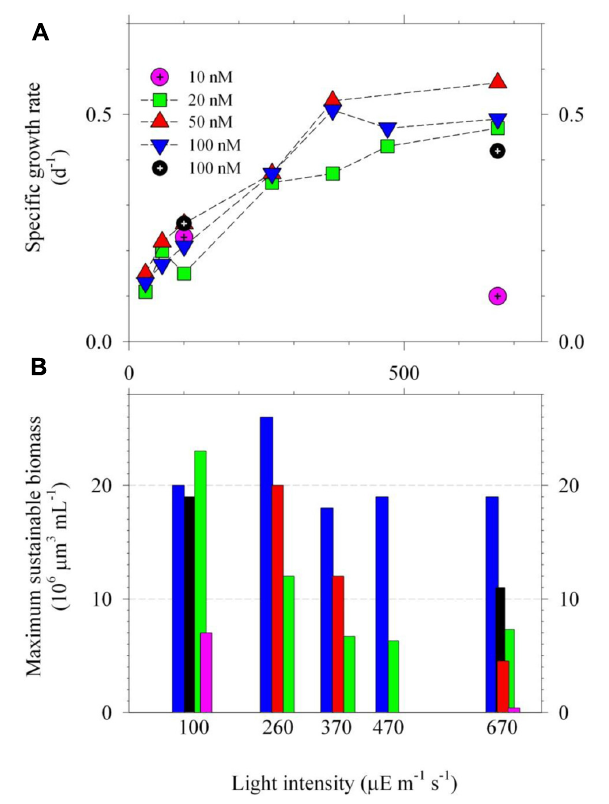
FIGURE 2 |The specific growth rates (A) and maximum sustainable biomass (B) of Trichodesmium grown under multiple-condition light and Ni treatments. The light intensities ranged from 30 to 670 μ E m − 2 s − 1 with intensities to be 30, 60, 100, 260, 370, 470, or 670 μ E m − 2 s − 1 (PAR).The total dissolved Ni concentrations were 20, 50, or 100 nM, which are equivalent to 13, 33, and 67 pmol L − 1 as inorganic concentrations, correspondingly.The specific growth rates were estimated by using data obtained from the exponential growth period.The r -square of linearity between growth time and the natural log of biomass were better than 0.98.The results of the growth rates of Figure 1 are shown here by using black and pink circle symbols. Excluding the data of the treatments with 10 nM Ni, the growth rates in the low light treatments ( < 370 μ E m − 2 s − 1 ) were significantly lower ( p < 0.01) than the high light treatments ( ≥ 370 μ E m − 2 s − 1 ).The biomass data for treatments with light